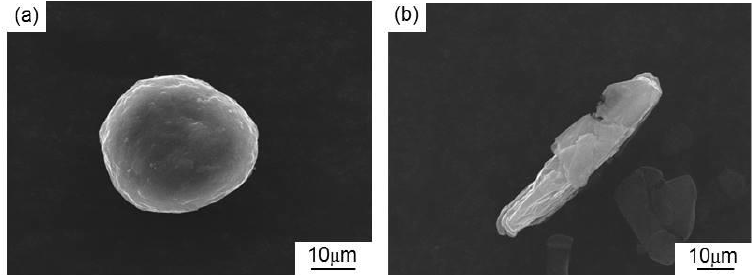
Figure 1. Micromorphologies of the as-received graphite: ( a ) mesocarbon microbead (MCMB) and ( b ) graphite flake (GrF).